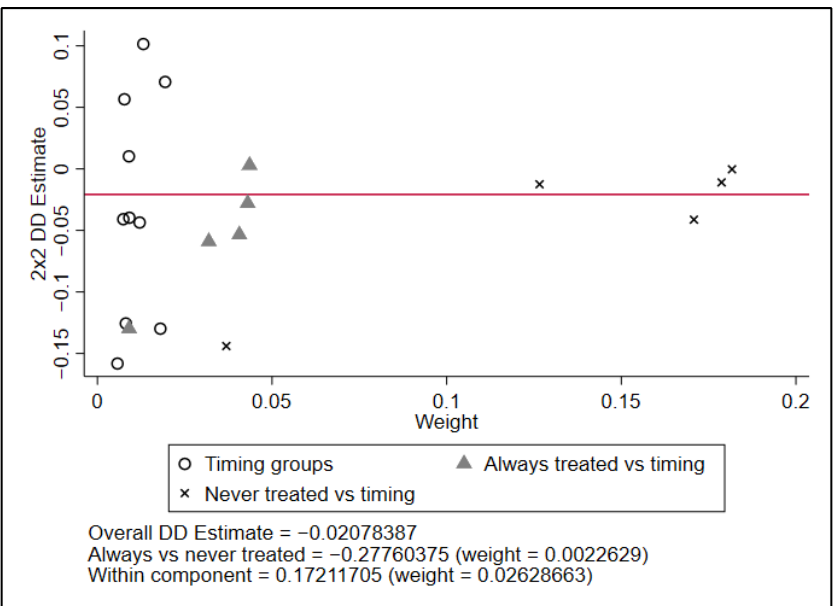
Figure A4. Goodman-Bacon Decomposition: the growth rate of GDP. This figure plots weights and